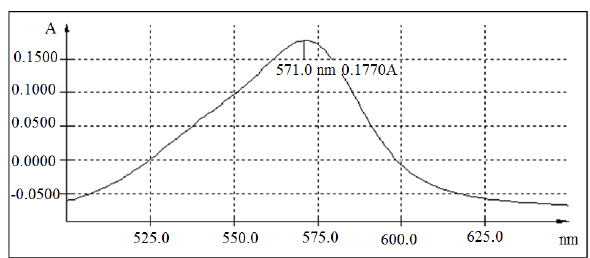
Fig. 6. Absorption spectrum of fructose P solution with α-naphthol in acidic medium with urea addition (6 mg/ml) and boric acid (12 mg/ml)